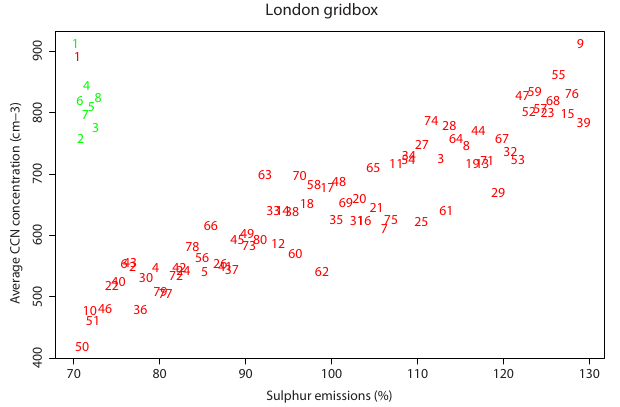
Fig. 6. June 2000 CCN concentrations for London versus the sul- phur emissions parameter values in the 80 original GLOMAP runs (red) and the new GLOMAP runs where all parameters were set low (green). The numbers show the experiment number in each of the designs: original and low.